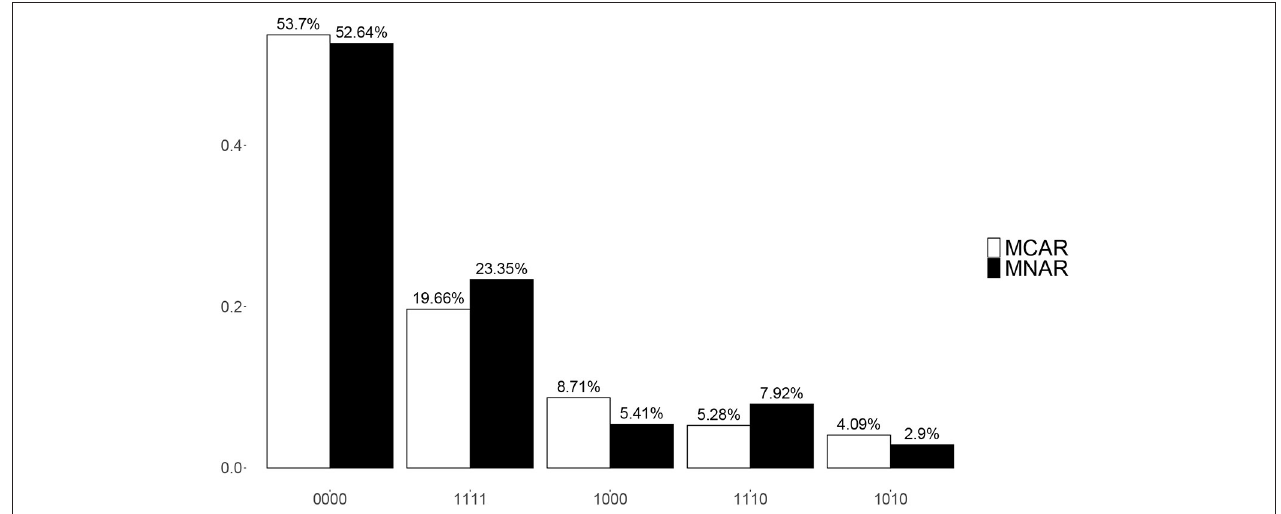
FIGURE 6 | Posterior mixing proportions for top 5 most frequent attribute patterns under MCAR and MNAR in the real